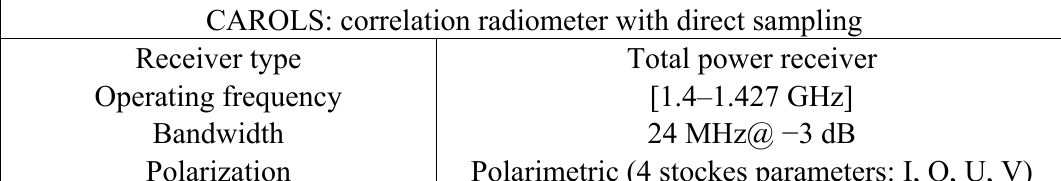
Table 1. Main technical specifications of the CAROLS